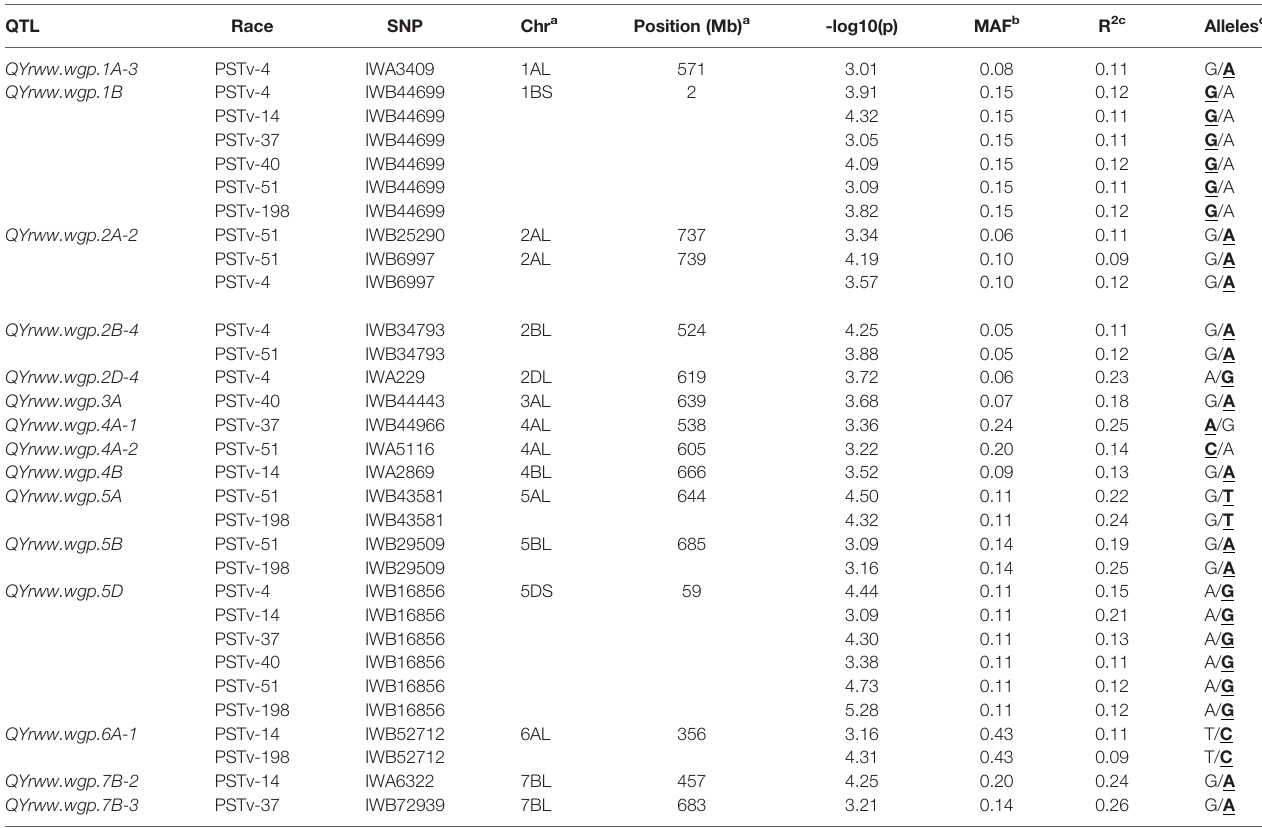
TABLE 2 | Resistance quantitative trait loci (QTL) identi fi ed in the winter wheat panel associated with stripe rust reactions evaluated at the seedling stage in the greenhouse with different races of Puccinia striiformis f. sp. tritici .